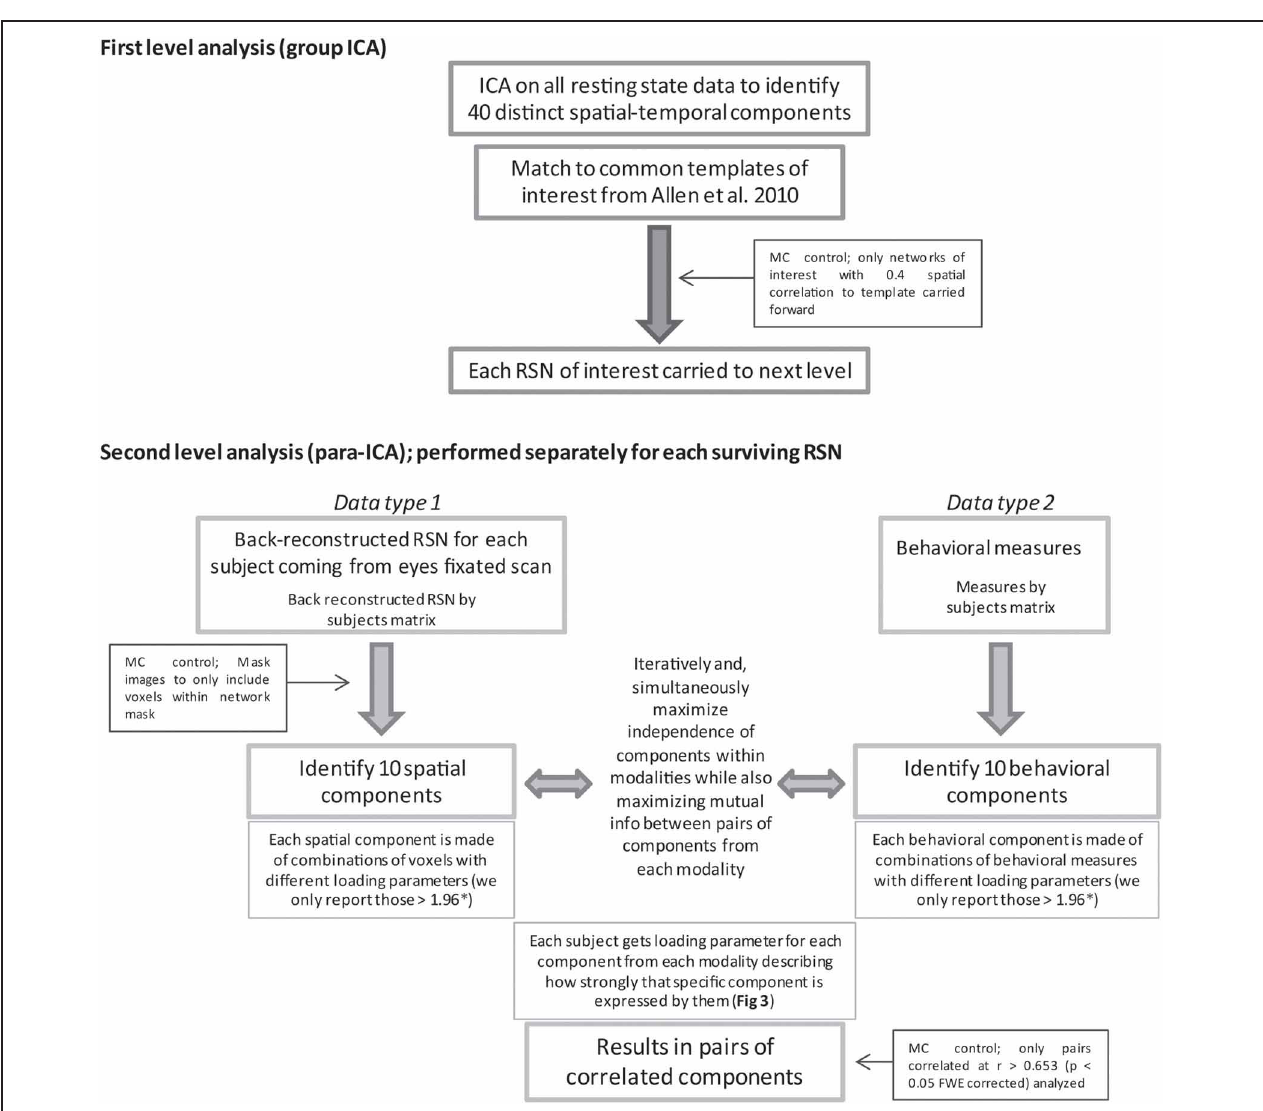
FIGURE 1 | Displayed is a flow chart of the methods used for this study. MC and ∗ indicate where steps were taken to limit multiple comparisons (MC). For in depth description of para-ICA analysis see the following papers (Calhoun et al., 2009; Liu et al.,